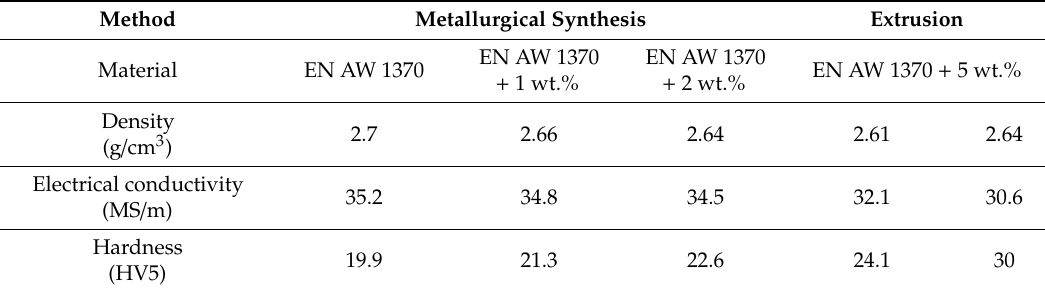
Table 1. Physical and mechanical properties of aluminium-glass fibre (Al-GF) composites with various reinforcement content obtained by various methods of